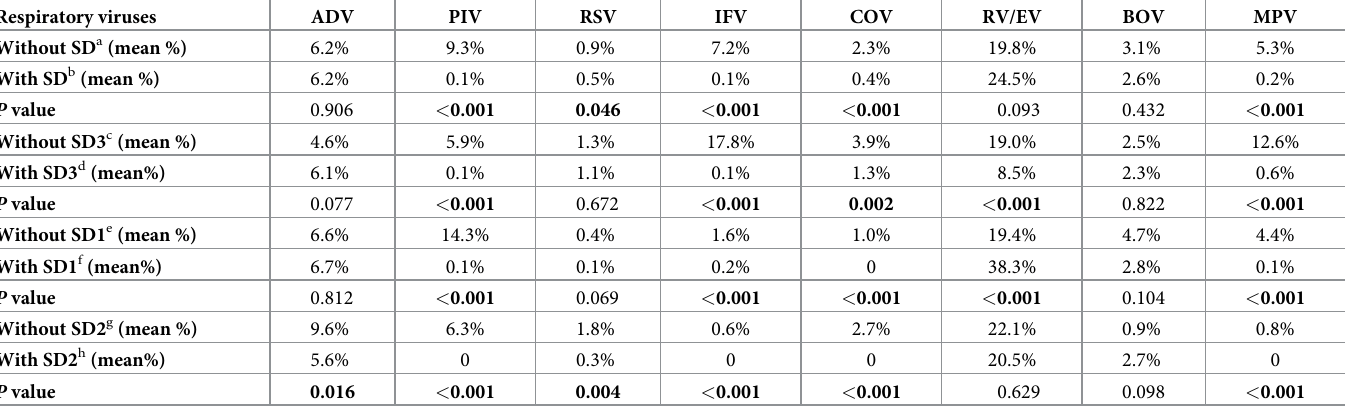
Table 3. Comparison of the mean positive rates for respiratory viruses between the periods with and without social distancing (SD): The Korean Center for Disease Control and Prevention dataset. Respiratory viruses ADV